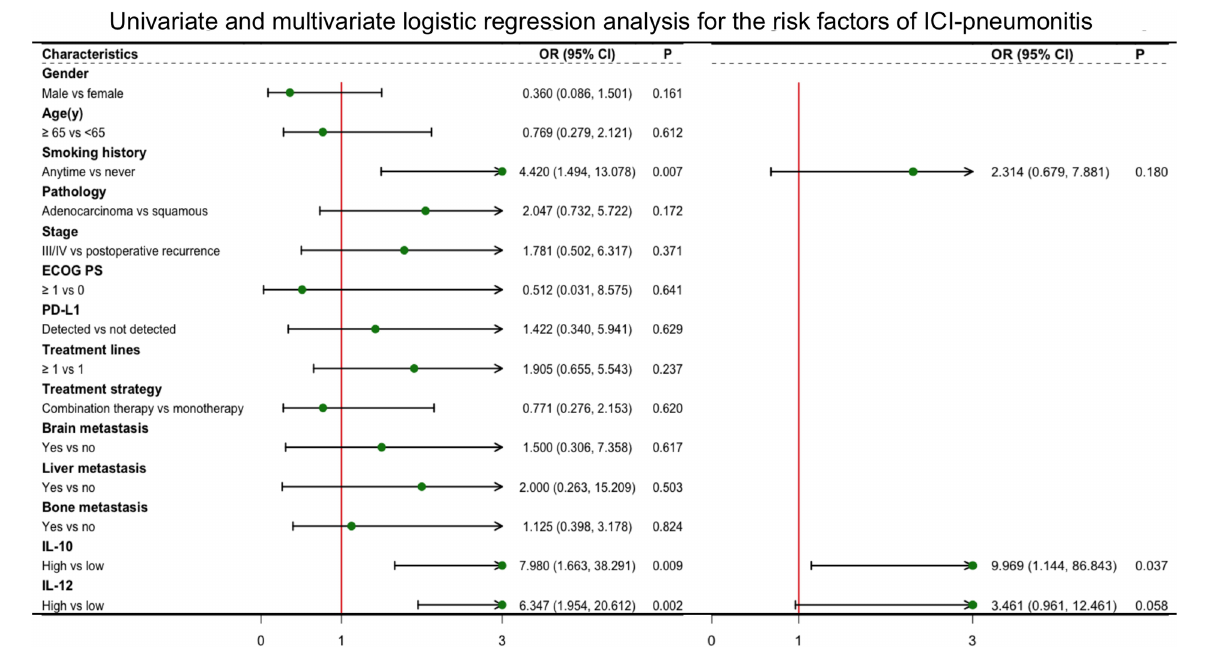
FIGURE 6 | Univariate and multivariate logistic regression analyses for the risk factors of ICI-pneumonitis. Characteristics in univariate models with p-value <0.05 were included in multivariate analysis. ICI-pneumonitis, immune checkpoint inhibitor-related